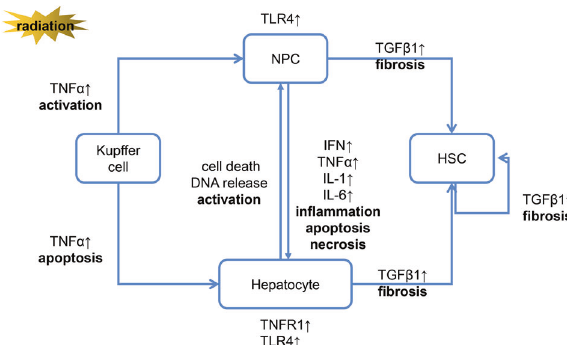
Fig. 2 The activation of in fl ammatory response pathways in a variety of cells is involved in the development of RILI. Radiation directly induces hepatocyte injury through oxidative stress and in fl ammatory response and then aggravates liver injury by activat- ing liver Kupffer cells and recruiting circulating immune cells to in fi ltrate and activate. In the late stage of RILI, NPCs and HSC are involved in the process of liver fi brosis mainly mediated by TGF- β 1. NPC: nonparenchymal cell; HSC: hepatic stellate